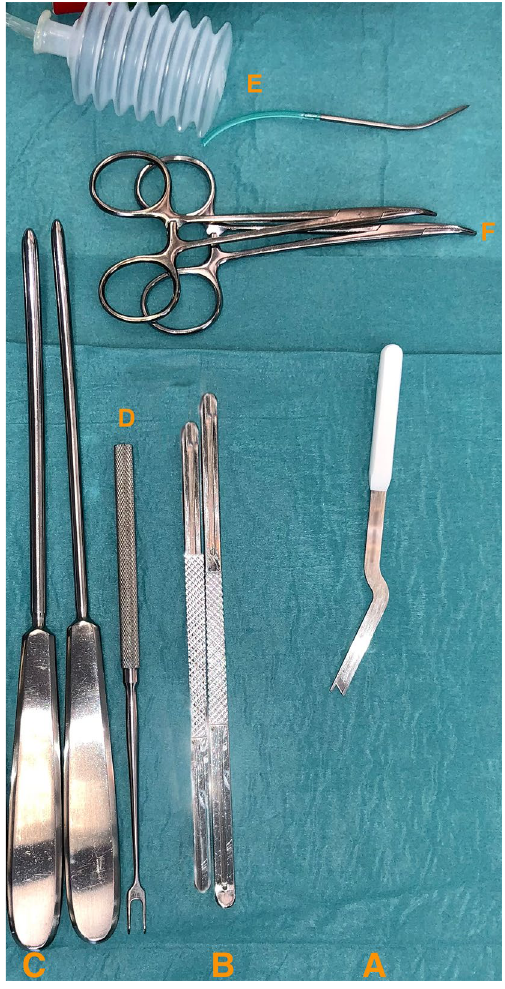
Figure 3. The instrumental system for MCTR: It consists of a two-component system: A. the special cutting knife, B. the protective guide. {SafeGuard Mini Carpal Tunnel Release System, Art.-No. 08-0001 and 08-0003, INTEGRA LifeSciences Corporation, USA}. The “Hegar” dilatators are marked with C. {KARL STORZ SE & Co. KG, Art.-No. 28147 SA, Germany} D. Fomon retractor, E. mini suction drain, F. Mosquito forceps. {MEDICON eG, Art.-No. 20.50.05, Germany; MEDICOPLAST International GmbH, Art.-No. 770 (107867), Germany; MEDICON eG, Art.-No. 15.45.12, Germany}. MCTR mini-open carpal tunnel